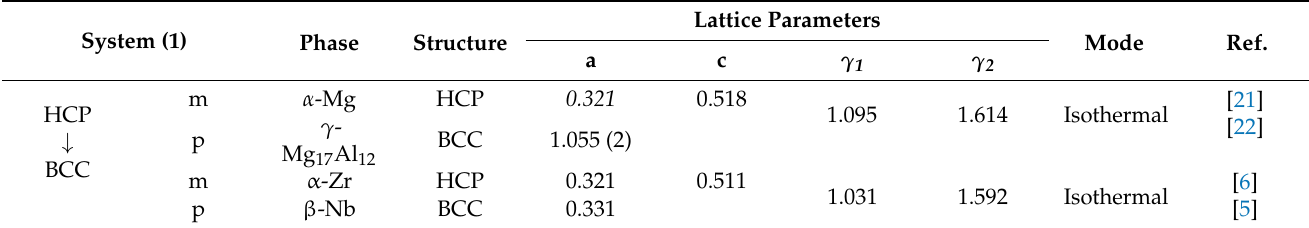
Table 1. Lattice parameters of phases investigated in this